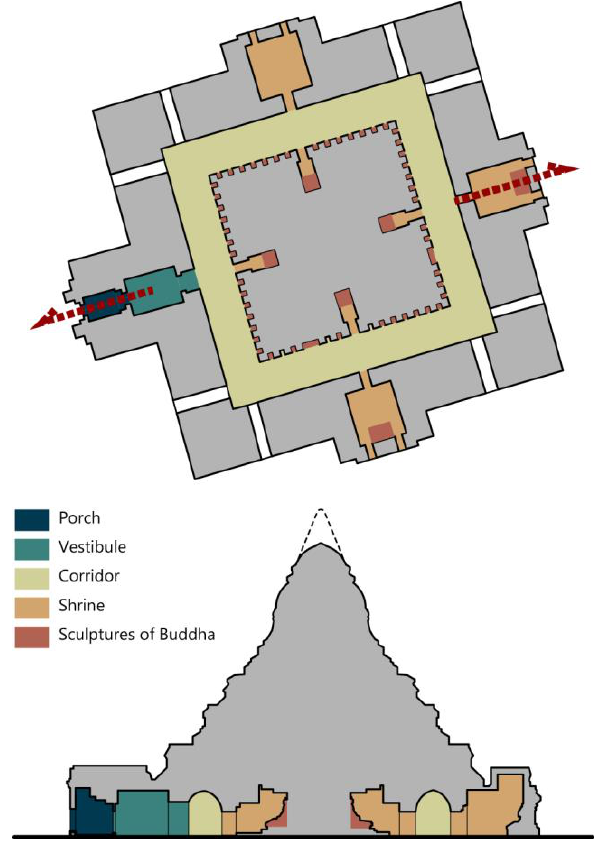
Figure 3. Architectural analysis